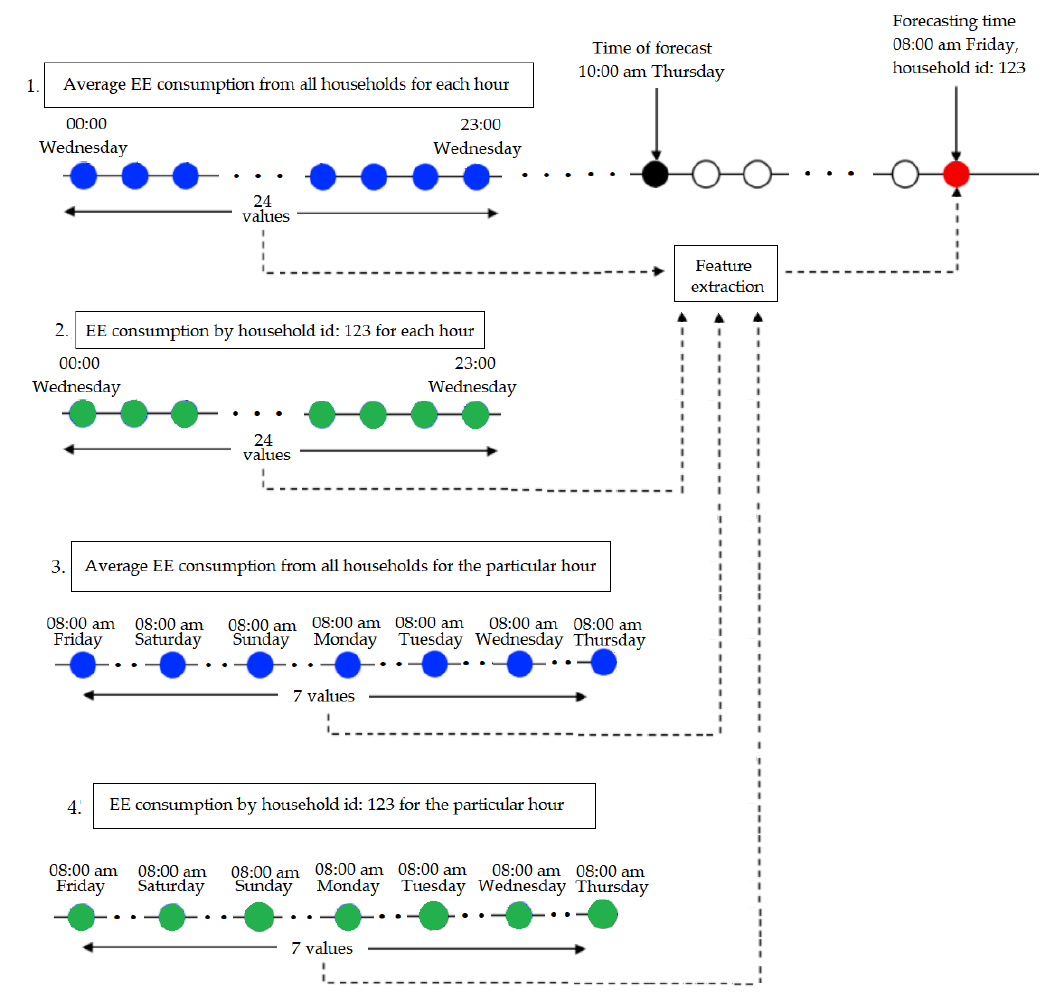
Figure 5. Domain-specific historical load feature extraction procedure.